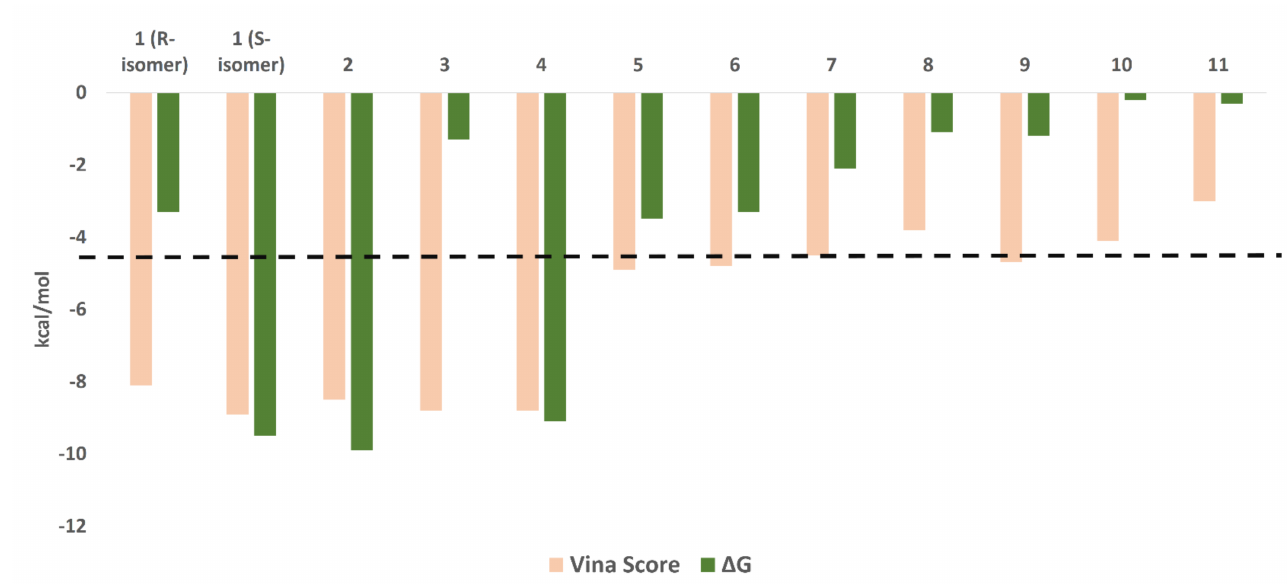
(Figure 4) revealed that the top docking poses (with average docking scores < − 7 kcal/mol) generated for each compound were almost of the same orientation, and hence we took the highest scoring pose for each compound as representative of their binding mode inside the M pro active site. Poses of docking scores > − 7 kcal/mol were significantly unstable during MDS of 25 ns (average RMSDs of 7.8 Å) and had higher values of binding free energies ( ∆ Gs) in comparison to their docking scores (~1.3 kcal/mol). It is worth noting that the remaining isolated compounds were also subjected to ensemble docking experiments against the M pro active site and their ∆ G values were calculated (Figure 4). However, all the generated poses for each compound were of docking scores > − 5 kcal/mol (i.e., low affinity towards the enzyme’s active site). Accordingly, this explains the in vitro inactivity of the remaining isolated compounds (up to the concentration of 10 µ M) except for compound 3 , which is clarified in the next section of the molecular dynamics study.